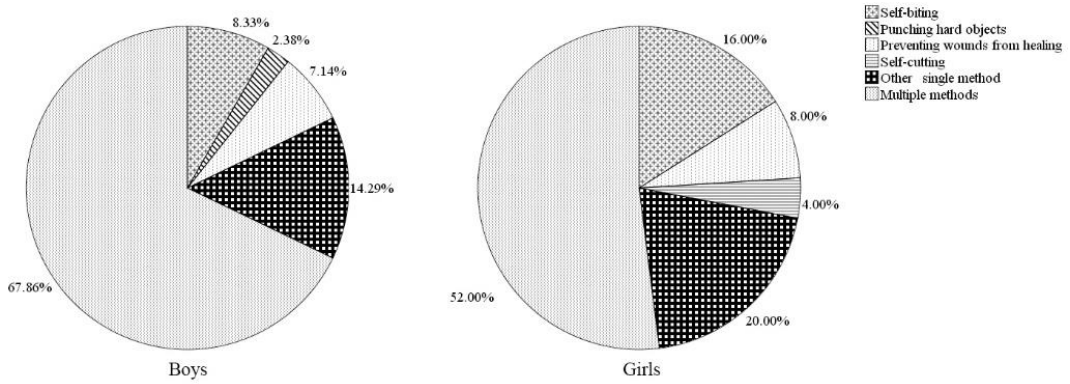
Figure 2. Proportion of the DSH methods in children with disabilities, by gender.